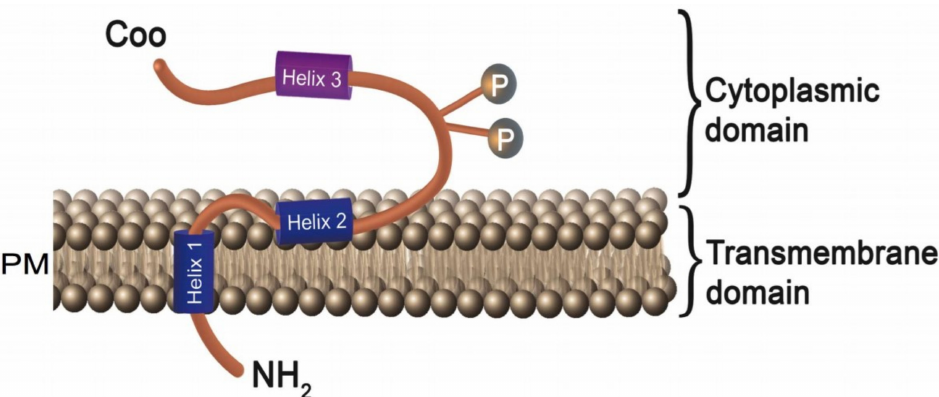
Figure 1. Structure of the human immunodeficiency virus (HIV)-1 accessory protein Vpu. Vpu protein is composed of three different distinct alpha helices: the N-terminus proximal transmembrane domain (Helix1-TMD: 6–29 residues) and a cytoplasmic domain that consists of two alpha helices (Helix 2: 32–52 residues, Helix 3: 57–72 residues). The first cytoplasmic helix shows amphipathic behavior with hydrophobic and polar residues on the sides. The hydrophobic portion is buried in the cell membrane, while the hydrophilic region is exposed to the cytoplasmic side. The second cytoplasmic helix is formed by acidic amino acids. Two phosphorylated serine residues, S52 and S56, interconnect these cytoplasmic